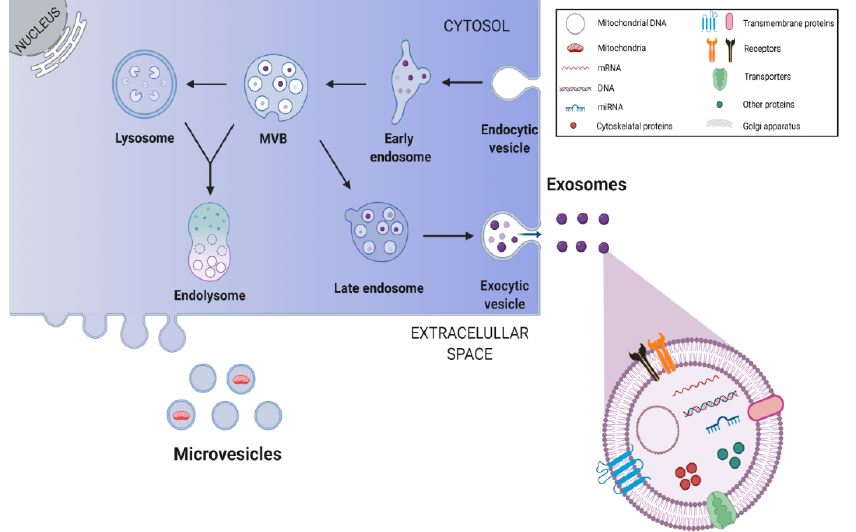
Figure 3. Biogenesis and release of stem cell-derived exosomes. Endosomes are produced through invaginations of the plasma membrane, which in turn generate intraluminal vesicles by budding into early endosomes and multivesicular bodies (MVBs). Through the endosomal sorting complex required for transport pathways, exosomes are formed and packaged within endosomes. Some of the MVBs fuse with lysosomes to form the endolysosome, where all components are digested, while others fuse with the plasma membrane resulting in exosome release into the extracellular space. This image was created with BioRender.com.